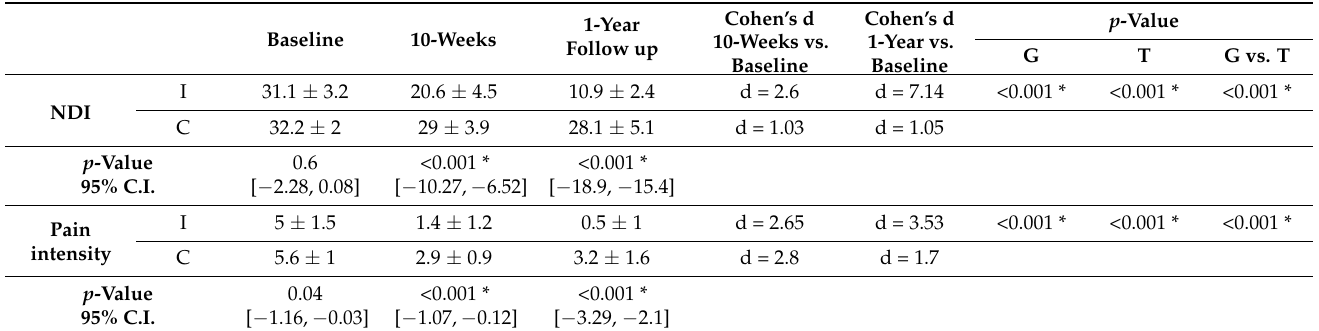
Table 3. The changes in pain and disability outcomes in interventional (DTTO) and control groups vs. time. NDI = neck disability index; Pain intensity is 0–10 where 0 is no pain and 10 is incapacitated; I = interventional group; C = control group; G = group; T = time; G vs. T = group vs. time; all values are expressed as means ± standard deviation; C.I. [] = 95% confidence interval; Cohen’s d value = d; * indicates statistically significant